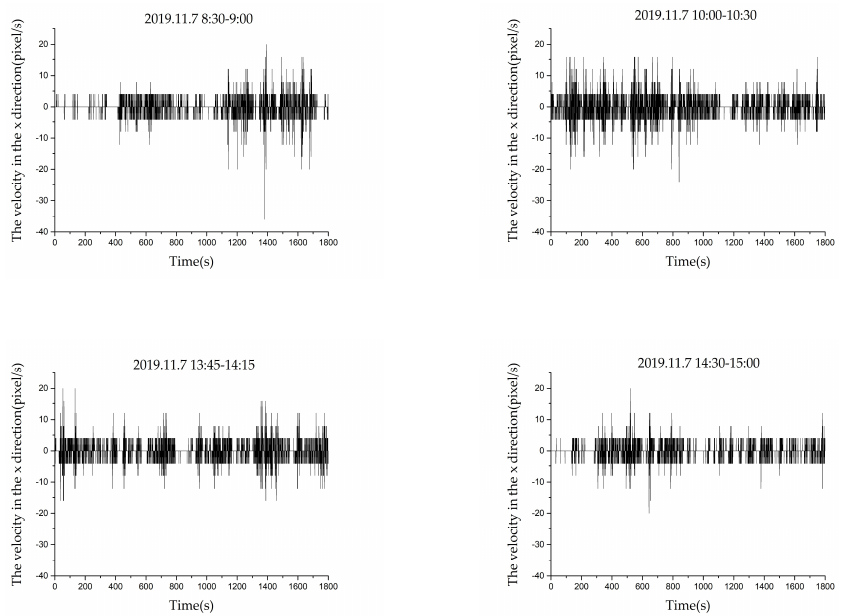
Figure 6. The velocity time history curve of the feature points of S 1,v in the first four monitoring